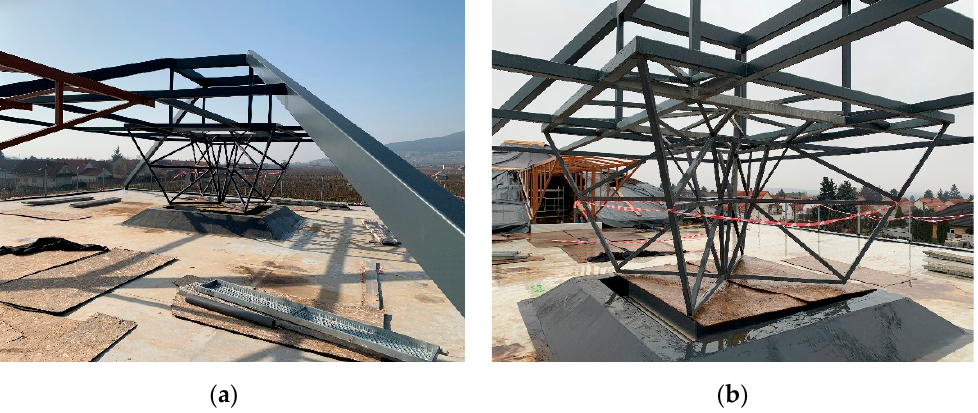
Figure 19. The developed wind catcher under construction in the prototype winery building in Vil- Vill á ny, Hungary. The steel frame structure—from the northeastern ( a ) and southwestern ( b ) point of lány, Hungary. The steel frame structure – from the northeastern ( a ) and southwestern ( b ) point of view—is completed and waits for the assembly of the glass wall surfaces (not yet view – is completed and waits for the assembly of the glass wall surfaces (not yet implemented).